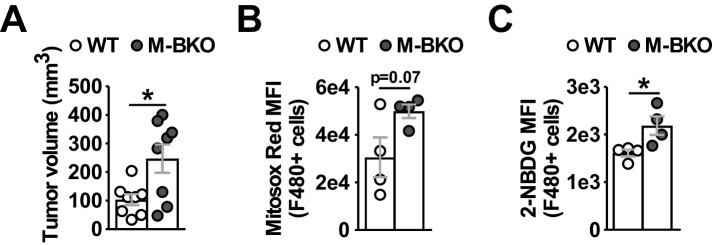
Increased mROS levels and glucose uptake in M-BKO TAMs.(A) Tumor volumes of B16-F10 subcutaneous allografts in 3-month-old female WT and M-BKO mice 14 days after tumor cell injection. Each mouse was injected with 500,000 B16-F10 cells in the right and left flanks, and tumors from each mouse were pooled for immune cell isolation and flow cytometry. N = 4 mice, with two tumors per mouse. (B, C) mROS production and glucose uptake by tumor-associated CD45+F4/80+ cells determined by flow cytometry (mean fluorescent intensities) of Mitosox Red and 2-NBDG staining, respectively. N = 4. Statistical analysis was performed using Student’s T test. Data are presented as mean ± S.E.M. *, p<0.05.